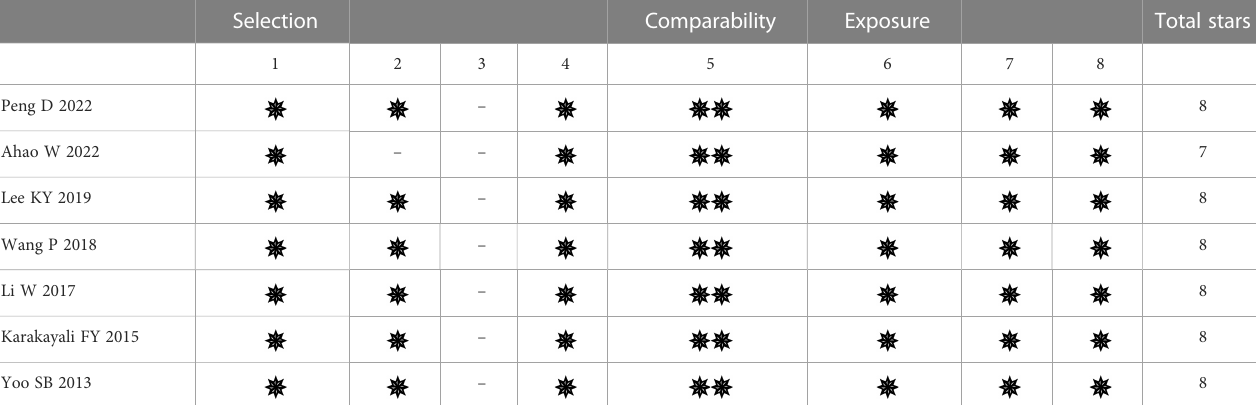
TABLE 2 Methodological quality of the included